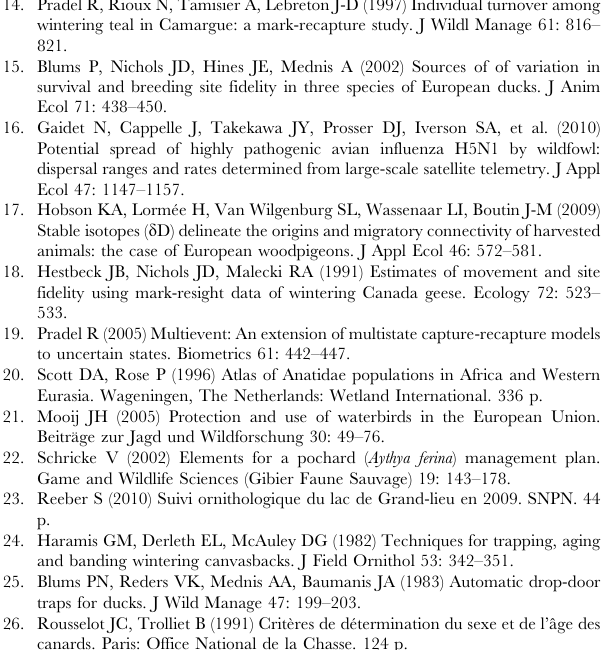
Figure S1 Example of definition of model constraints in E- SURGE using the GEPAT and GEMACO modules. Figure S2 Goodness-of-fit tests in multi-events models. Figure S3 Computations of seasonal and annual survival rates using E-SURGE outputs. (PDF) Dataset S1 Matrix of the individual capture-mark-recaptures/ recoveries histories of pochards caught on Grand-Lieu as formatted for the multi-event approach adopted in our study.